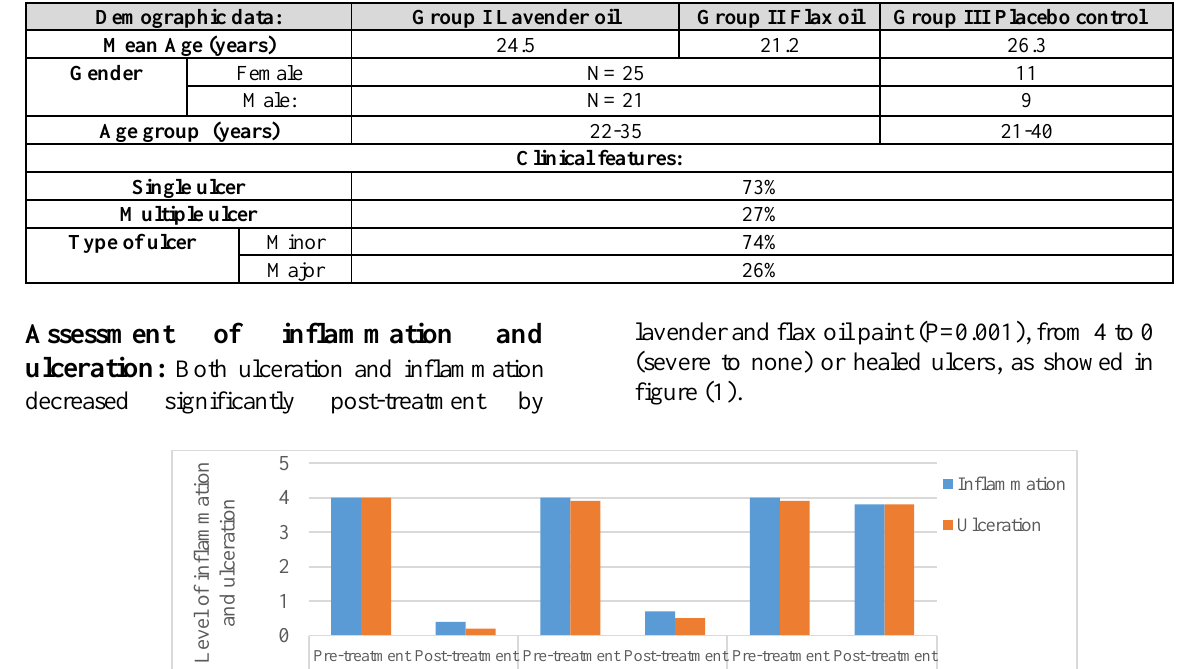
Table 1: Demographic and clinical features of patients with recurrent aphthous ulceration